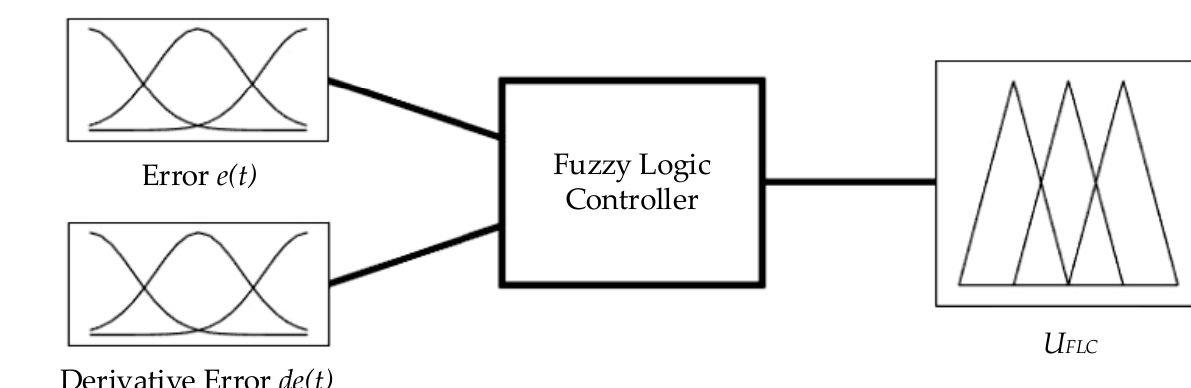
Figure 4. The fuzzy logic controller for valve control.